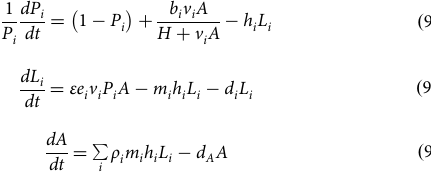
Equation (9a) describes the population dynamics of plant species i ( D. wrightii, D. discolor , or P. parvi fl ora ). Equation (9b,c) give the dynamics of M. sexta : L i gives the larvae density on plant species i , which recruit into the adult population, A . Pollination is described by the term b i v i A /( H + v i A ), where b i is the per capita growth of plant species i due to pollination by the antagonist, v i is the visitation rate to plant species i per antagonist adult, and H is the saturation constant for polli- nation. Oviposition is given by ε e i v i P i A , where e i is the oviposition ef fi ciency (number of eggs laid per fl oral visit) and ε is the fractional increase in egg pro- duction due to nectar-feeding at A. palmeri . Floral visits lead to both pollination and oviposition because these behaviors have been shown to be tightly linked in M. sexta 19 . Pollination and oviposition are given by saturating and linear functions, respectively, based on our data (Supplementary Data 1). Herbivory damage is given by the term h i L i , where h i is the herbivory rate per larvae on plant species i . Larvae mature at rate m i h i L i , where m i is the maturation ef fi ciency (fraction of larvae maturing on plant species i ). Larval mortality on plant species i is d i , adult mor- tality is d A , and ρ i is pupae survival (due to data constraints, we include pupae survival in our estimates of maturation m i , set ρ i = 1, and drop ρ i from equations hereafter). Equation (9a) gives the dynamics of the alternative larval host plant, P. parvi fl ora ( b p = 0 and cannot evolve), which can coevolve attraction and defense. The alternative nectar source, A. palmeri , is incorporated within the model via the parameter ε